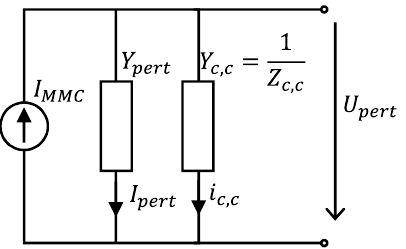
Figure 17. MMC impedance model with additional coupling